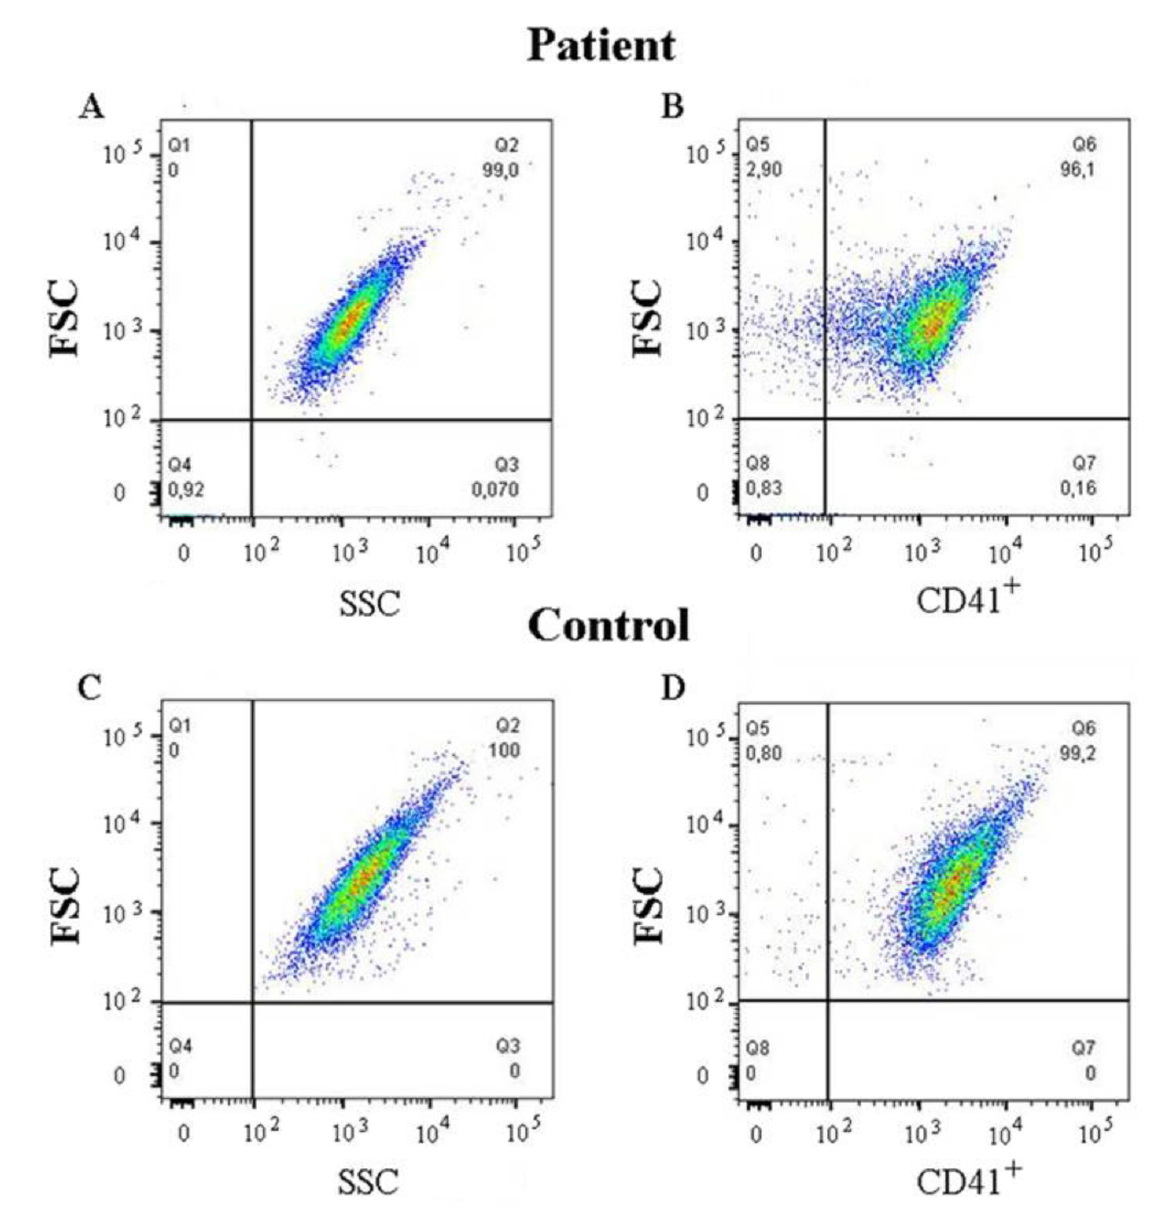
Figure 2. Flow cytometric analysis of CD41 expression in PRP. Representative FSC vs SSC and FSC vs CD41 flow cytometry plots. ( A and B ) PMM2-CDG patient. ( C and D ) Healthy